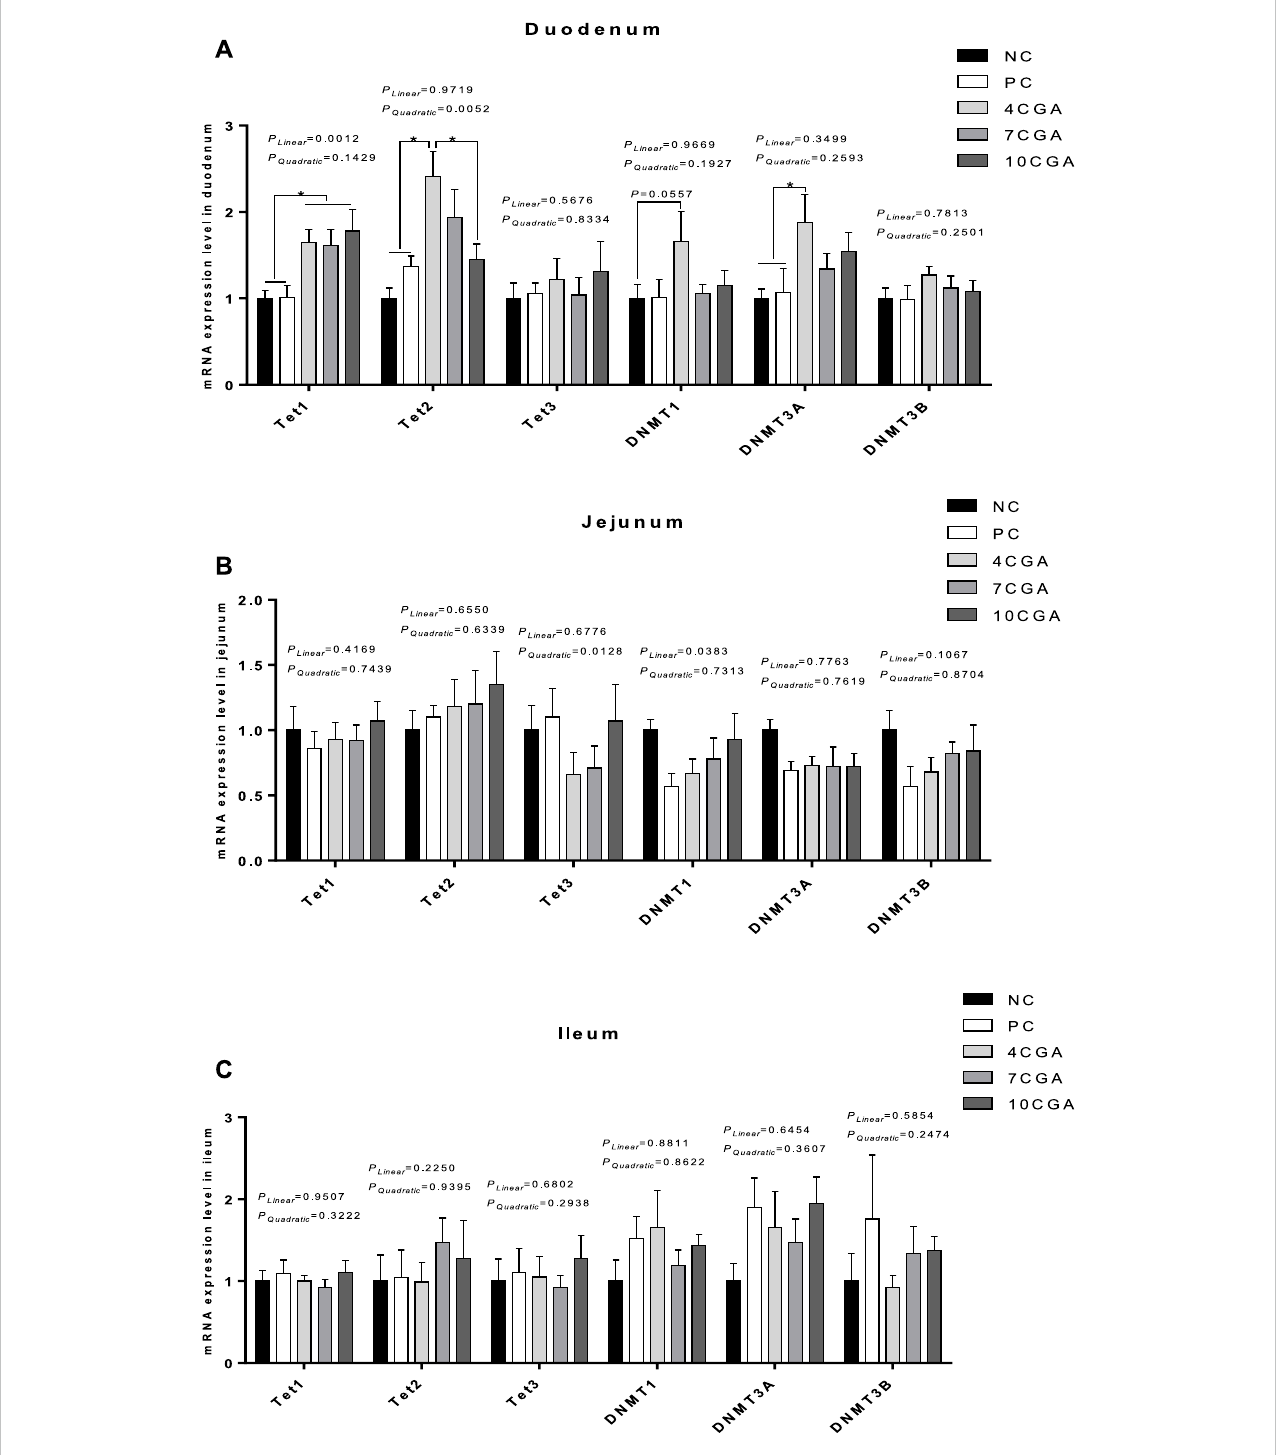
FIGURE 6 EffectsofinovofeedingofchlorogenicacidonmRNAexpressionofDNAmethylation-relatedenzymesof42d-heatstressedbroilers. (A) Duodenum; (B) Jejunum; (C) Ileum. * indicates a signi fi cant difference between treatments ( p < 0.05), n =